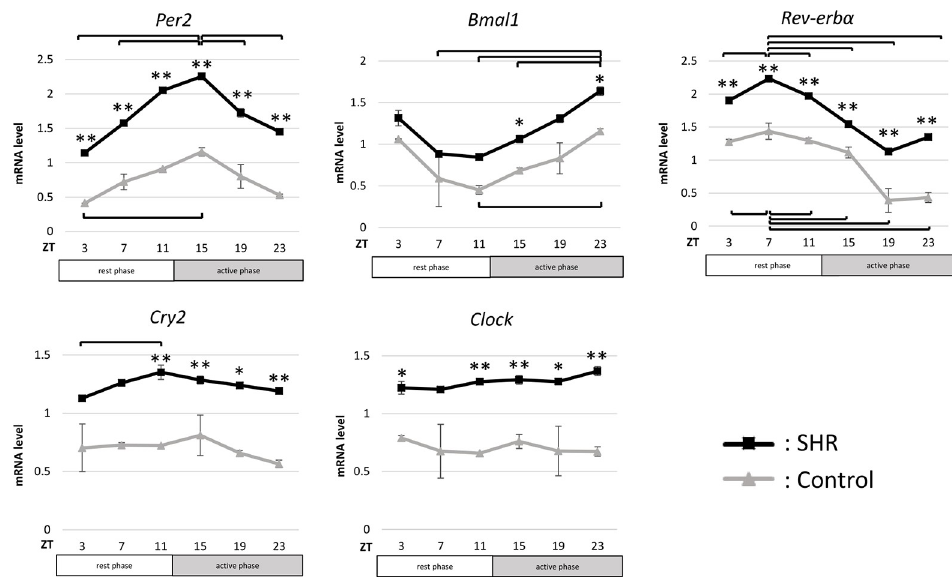
Fig 2. Changes in clock gene mRNA expression in bladders from Wistar rats (control) and spontaneously hypertensive rats (SHR) bladder. Per2 , Bmal1 , Rev-erb α , Cry2 , and Clock mRNA expression rhythms in the bladder in control and SHR under 12-h light/12-h dark cycle. n = 6 for control, n = 6 for SHR at each time point. Statistic analyses were performed using a one-way analysis of variance. � p < 0.05, �� p < 0.01. ZT: zeitgeber time; Per2 : period 2; Bmal1 : brain and muscle aryl hydrocarbon receptor nuclear translocator-like protein 1; Rev-erb α : nuclear receptor subfamily 1, group D, member 1; Cry2 : cryptochrome 2; Clock : circadian locomotor output cycles kaput.